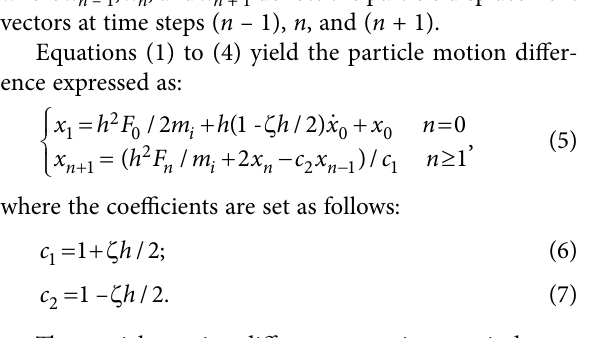
Remove repeatly until all cables have been removed